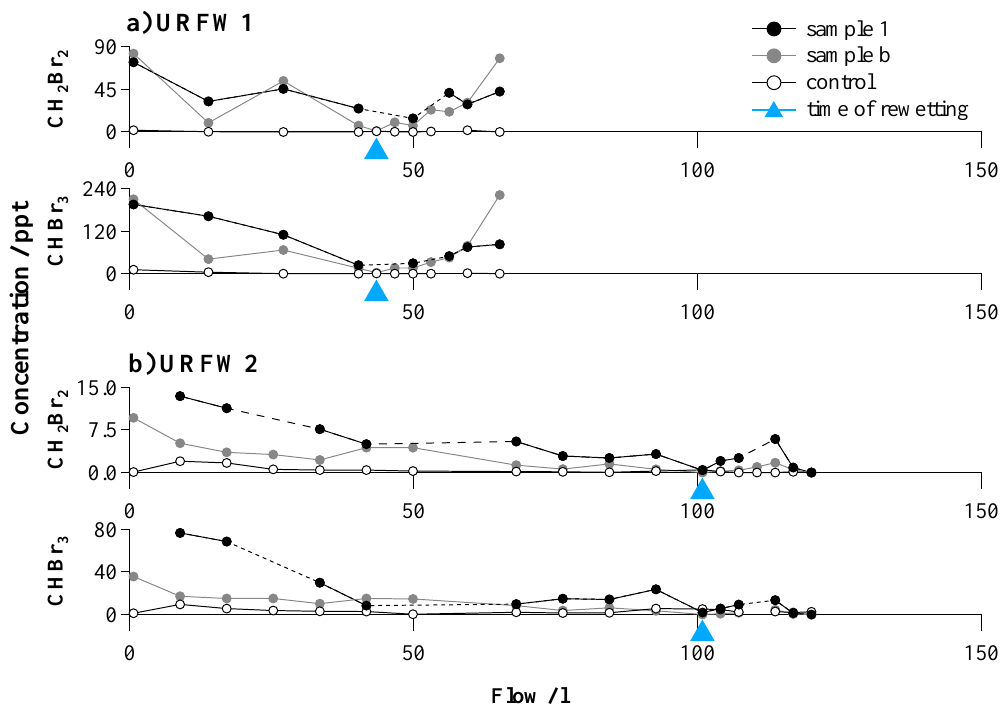
Figure 6. Desiccation of U. intestinalis followed by rewetting (URFW experiments). Changes are shown relative to total flow (L). Exper- iments conducted at different times are denoted by individual numbers (e.g. US1, US2). Within these experiments replicates in different flasks (Fig. 1) are denoted by individual letters (UL1a, UL1b), see Table 1 for further details. Error bars are taken from the daily variations in calibration